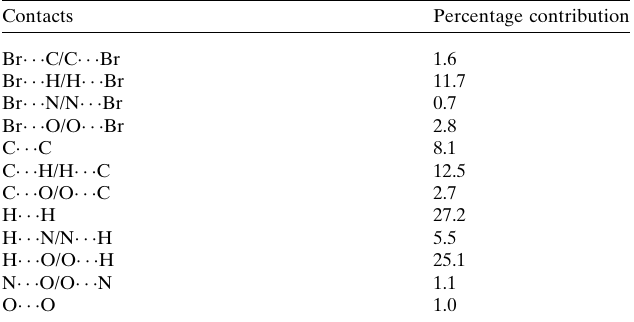
Table 2 Summary of the various contacts and their contributions to the Hirshfeld surface.